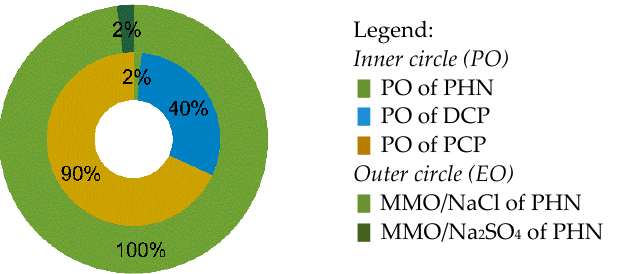
Figure 2. Maximum removal % of phenol (PHN), 2,4-dichlorophenol (DCP), and pentachlorophenol (PCP) achieved by 300 min of photooxidation (PO), 120 min of electrooxidation with MMO in NaCl, and 160 min with MMO in Na 2 SO 4 .